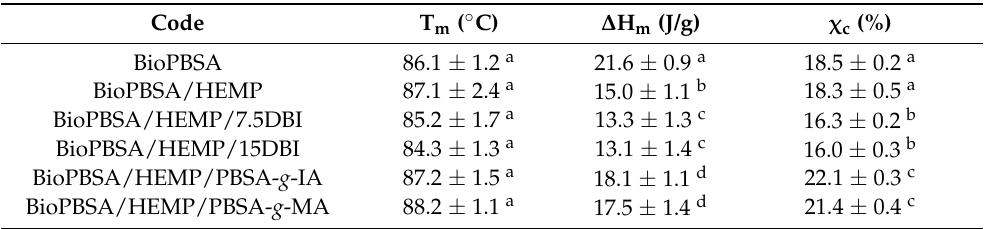
Figure 3. Differential scanning calorimetry (DSC) thermograms of BioPBSA/HEMP composites. Table 3. Main thermal parameters of the composites with different amounts of hemp fiber in terms of melting temperature (T m ), normalized melting enthalpy ( ∆ H m ), and degree of crystallinity ( χ c